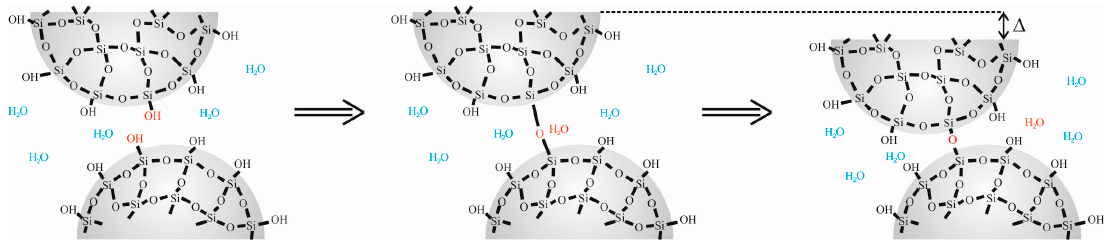
Figure 2. Illustration of syneresis, pore liquid in blue and formation of a new siloxane bond in red.